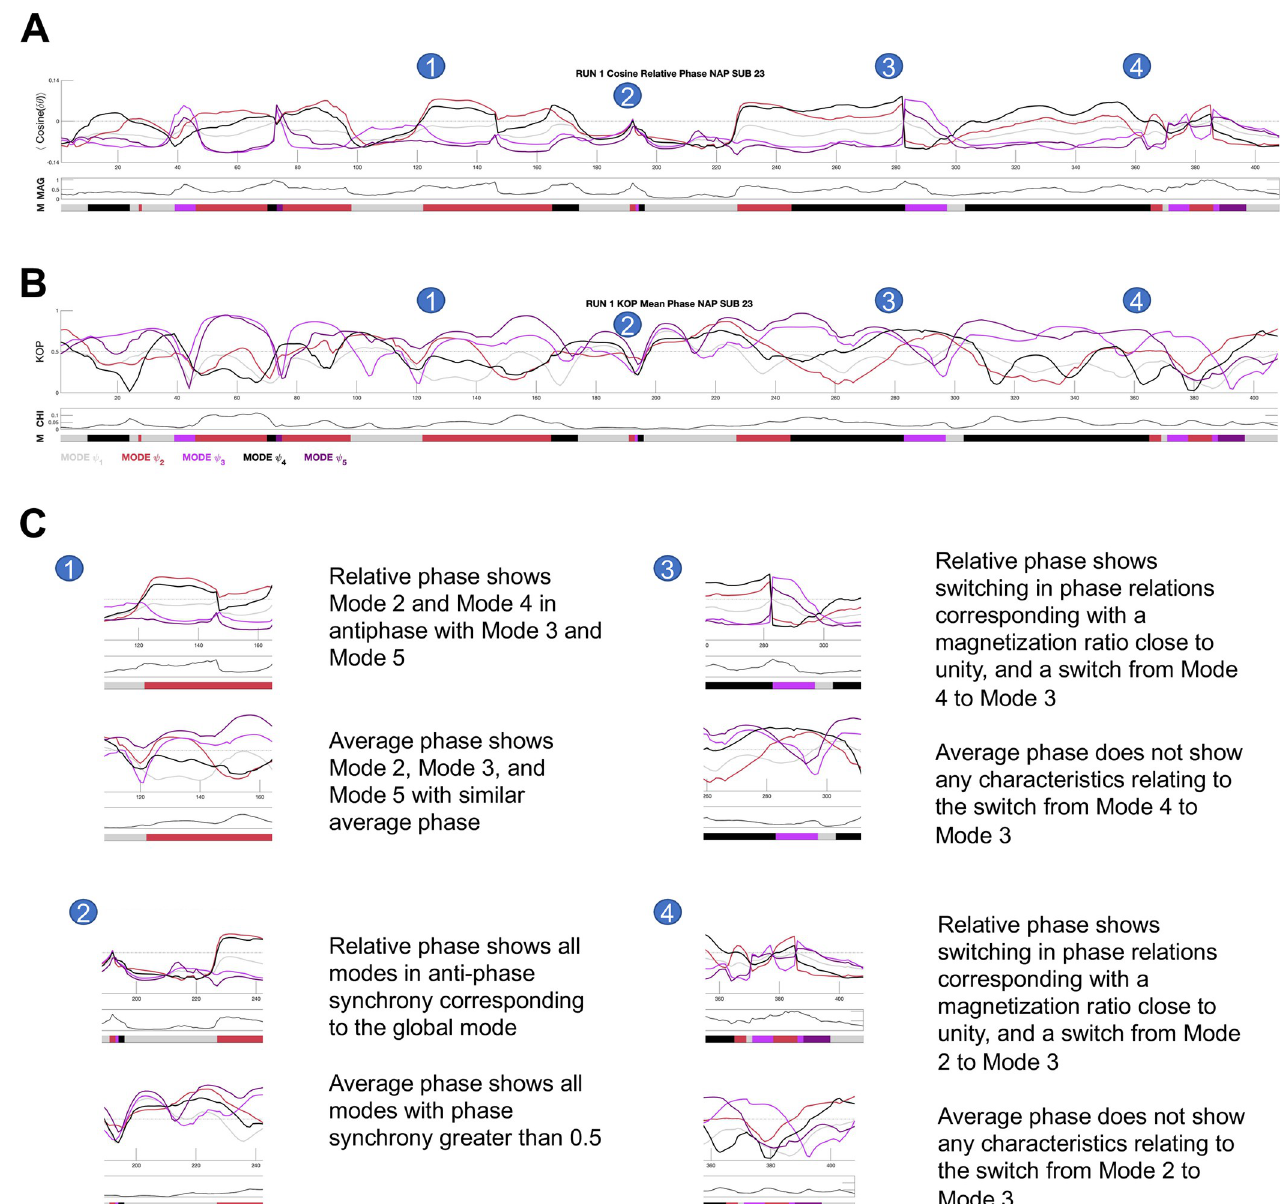
Fig 7. Time-series for the relative phase order and the Kuramoto order parameter for one NAP subject. A) Time-series for the cosine of relative phase or instantaneous phase-locking for a single subject. B) Time-series for the Kuramoto order parameter or average phase for a single subject. C) Blow-outs showing how relative phase is more informative than average phase for the dynamics of brain activity in one subject. MAG, magnetization ratio; KOP, Kuramoto order parameter, CHI, chimerality.